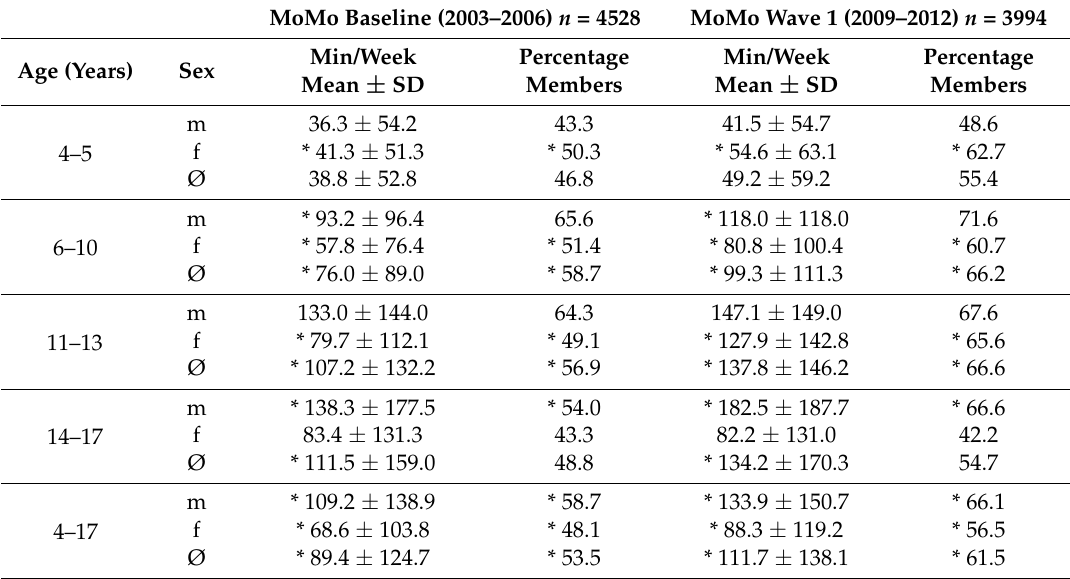
Table 2. PA of German children and adolescents in setting sports